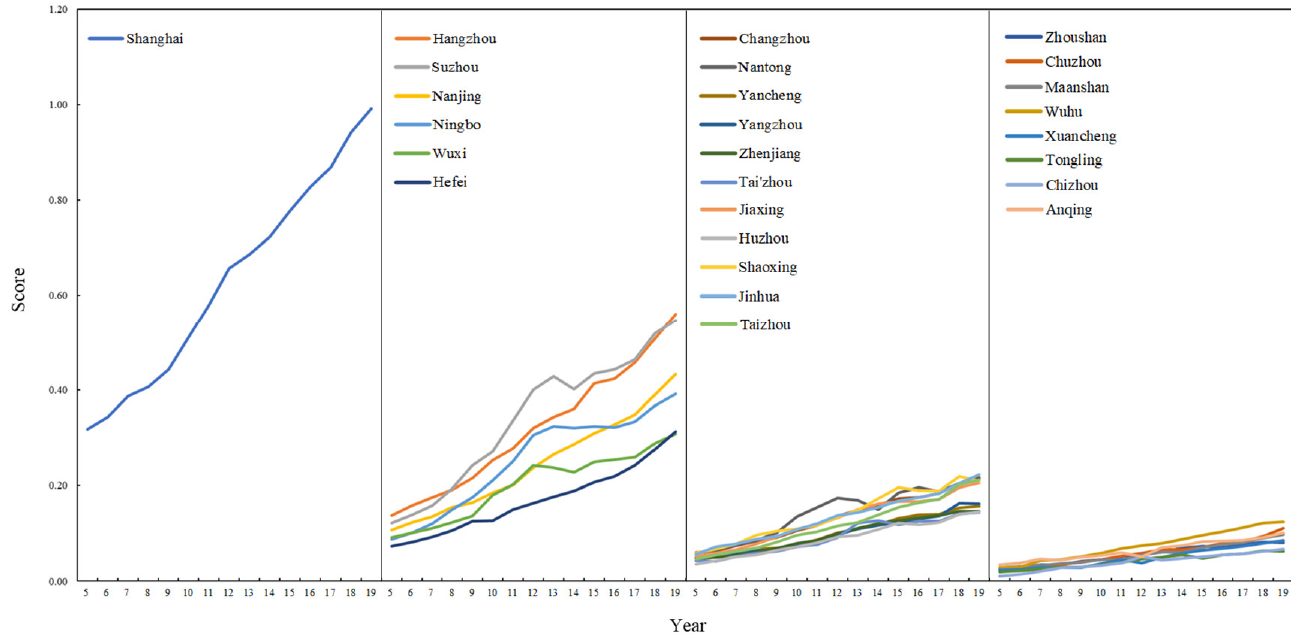
Figure 2. Evaluation of cities’ comprehensive quality from 2005 to 2019 in the YRDUA. After the analysis of city-pair linkage, the node city linked to the whole regions was obtained by Formula (4), representing the connection to all the other cities in the YRDUA and the status in the regional integration (Figure 4). The connectivity of Shanghai is worthy of the highest ranking, owing to the intensive attraction of elements (human, products, capital, information flow, etc.) from the region. The next ranks are Suzhou and Hangzhou, and compared with the quality score, the interconnectivity of Suzhou is larger than Hangzhou, meaning the key position of the conduction function of Suzhou in the network.